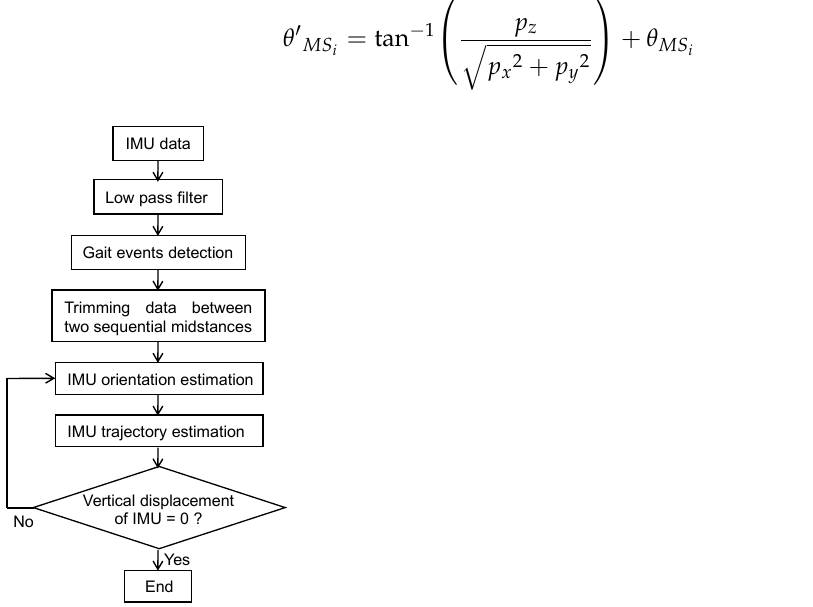
Figure 4. Flow chart of the data postprocessing steps for the estimation of foot trajectory from foot- mounted IMU.